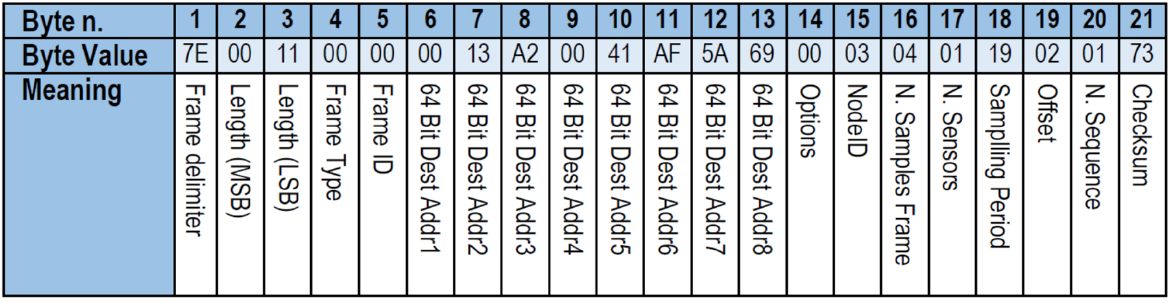
Figure 5. Configuration frame sent by the Coordinator Node to one Smart Measuring Node.